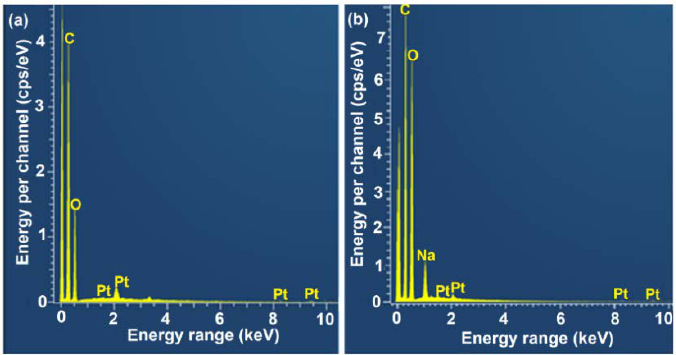
Figure 4. EDX spectra of ( a ) untreated C. pentandra fiber and ( b ) treated C. pentandra fiber.